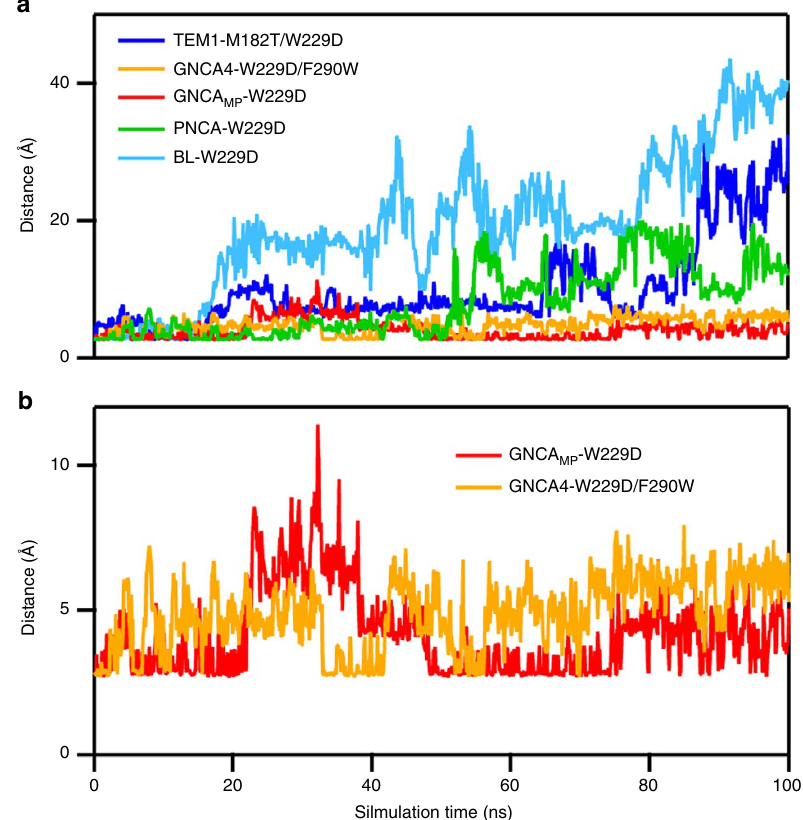
Figure 10 | Distance monitoring during our simulations of selected b -lactamases. Monitoring the time evolution of the distance (in Å) between the nitrogen atom of the 5(6)-nitrobenzotriazole transition-state analogue (TSA) and the closest oxygen atom of D229, in simulations of enzyme-TSA complexes of the TEM-1 (blue), Bacillus licheniformis (purple), GNCA MP (red), GNCA4 (orange) and PNCA (green) b -lactamase variants. Shown here are ( a ) a comparison of calculated distances for all systems, and ( b ) a close-up for the ancestral b -lactamases. Note that in b , the large values obtained for the GNCA MP b -lactamase variant between B 20 and 40ns of simulation time are due to flipping of the TSA in the binding pocket, and not due to dissociation from the active site as is the case for the modern b -lactamases and the PNCA b -lactamase shown in a . All values shown here are averages over three independent trajectories, which were obtained as described in the Methods